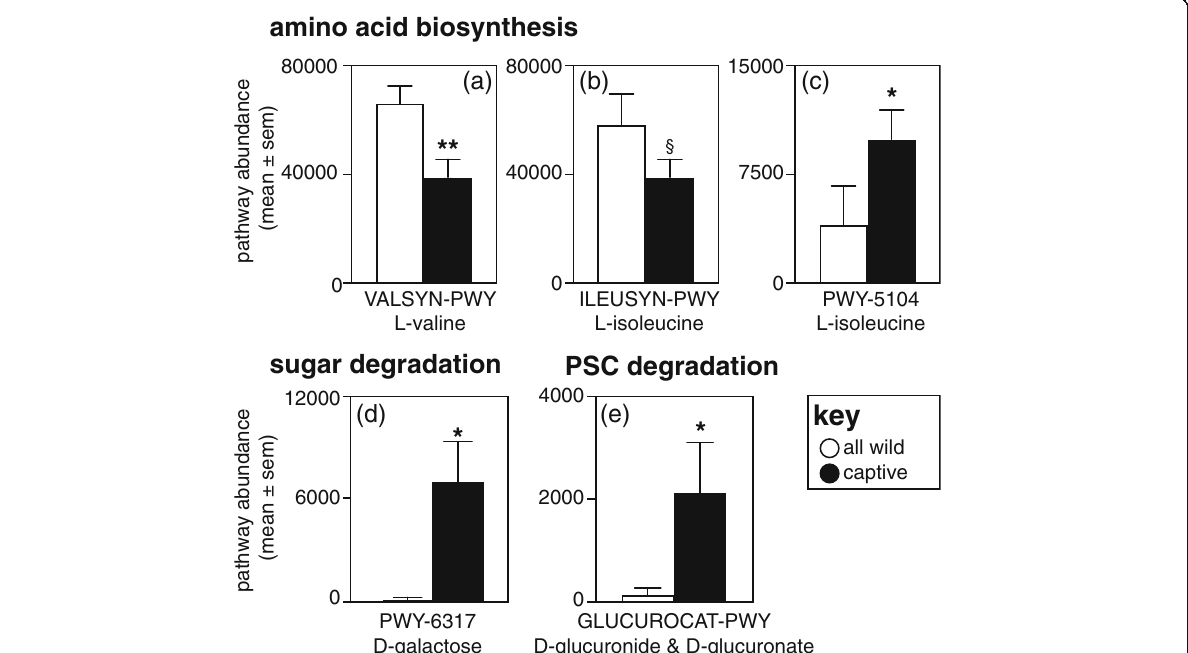
Fig. 4 Gut microbiome function in three populations of Coquerel ’ s sifakas ( Propithecus coquereli ), including wild populations living in the Anjajavy Protected Area and Ankarafantsika National Park (white bars) and the captive population housed at the Duke Lemur Center (DLC, black bars). Depicted are results of key metabolic pathways that were differentially enriched in either wild or captive populations, including the biosynthesis of essential amino acids a L-valine and b , c L-isoleucine, and the degradation of d D-galactose via the Leloir pathway and of e D-glucuronide and D-glucuronate. The identifying PWY codes of the metabolic pathways are from the MetaCyc database. § p < 0.10; * p < 0.05; ** p <